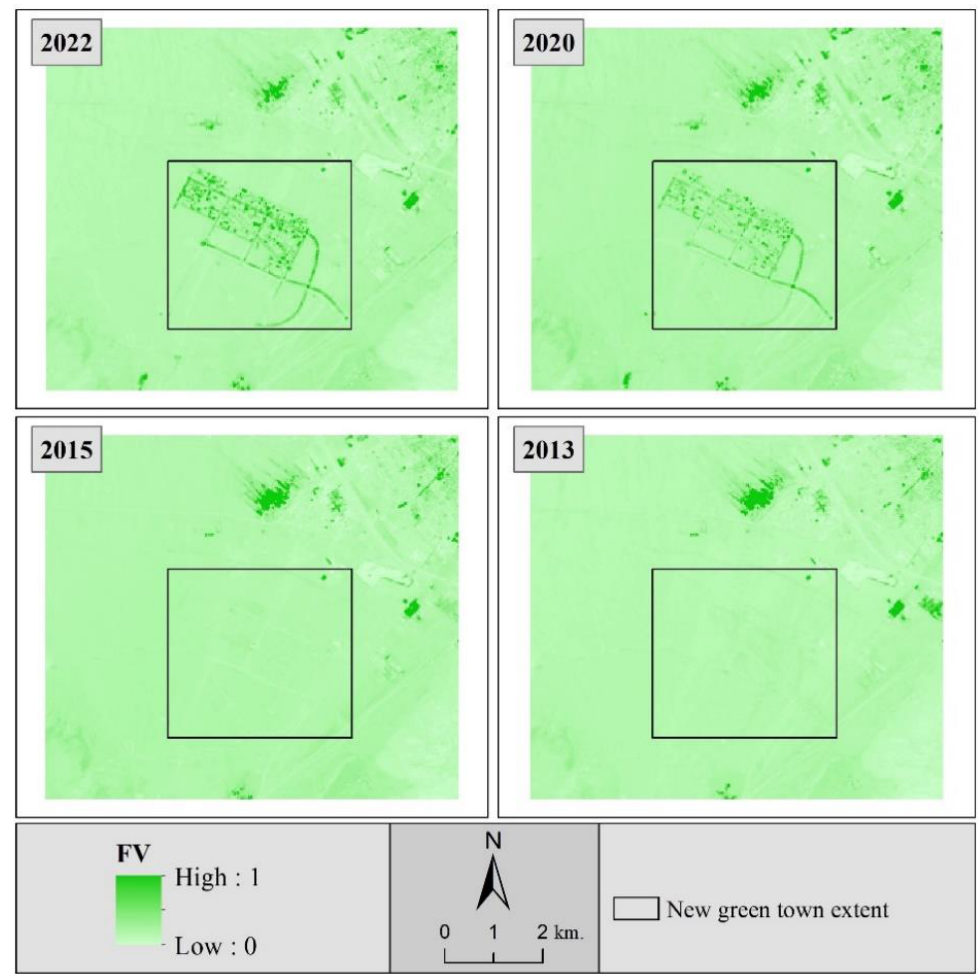
Figure 6. Fractional vegetation cover (FVC) maps of the studied area for 2013, 2015, 2020 and 2022. Table 3. Statistics (masked by the built green town subsurface) of the normalized difference vegetation index (NDVI) and fractional vegetation cover (FVC) changes according to the studied years. NDVI